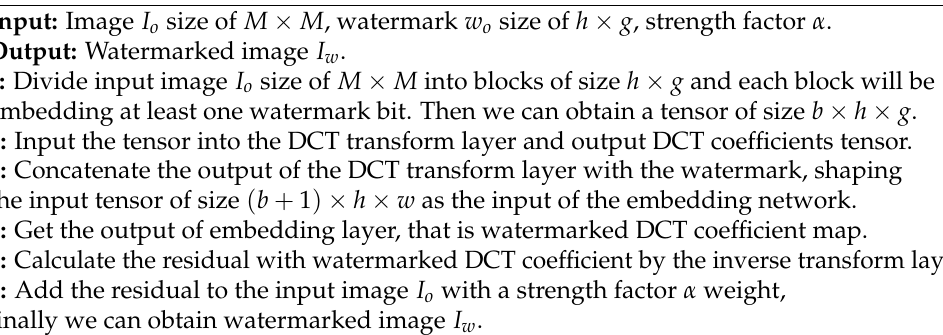
Algorithm 1 Embedding